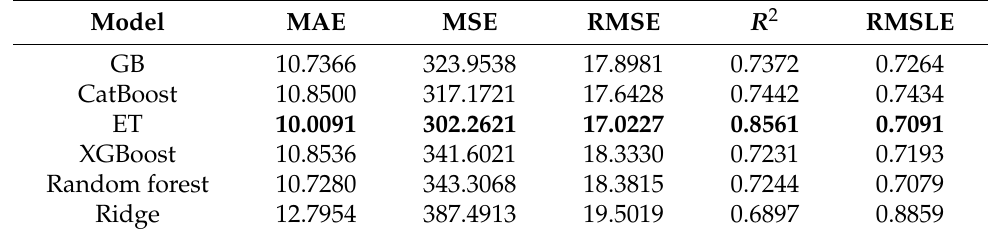
Table 2. The results on training dataset for 6 models. The ET outperforms than other 5 models.